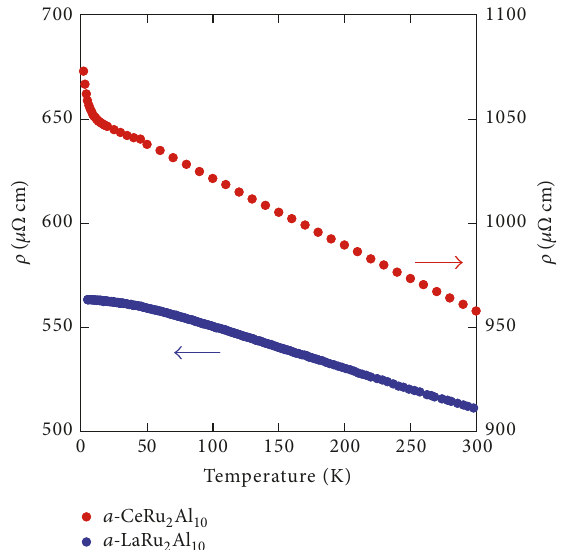
Figure 3: Temperature dependence of the resistivity 𝜌 for 𝑎 -CeRu 2 Al 10 and a -LaRu 2 Al 10 alloys.